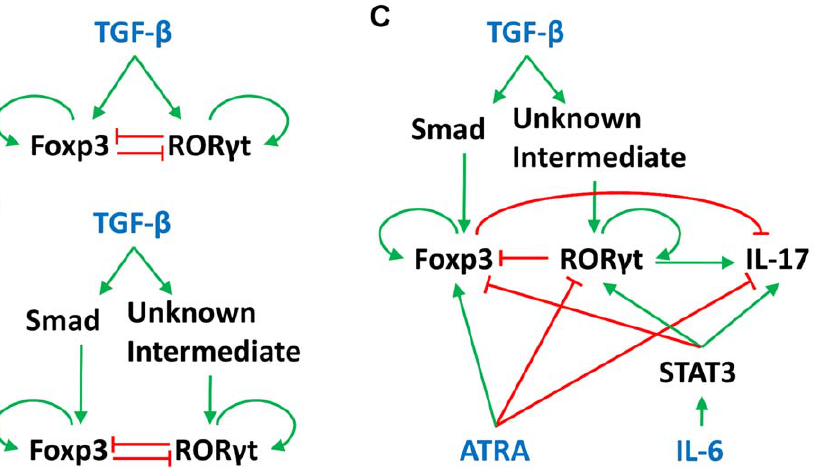
Figure 2. Influence diagrams of the mathematical models. A. Symmetrical model without intermediates. B. Symmetrical model with intermediates. C. Asymmetrical model with three input signals: TGF- b , ATRA, and IL-6.